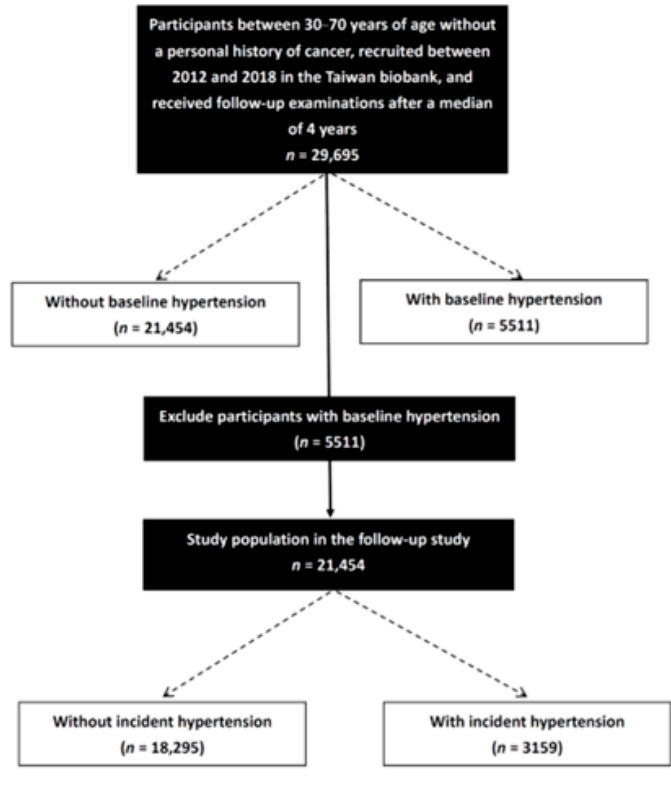
Figure 1. Study Figure 1. Study flowchart.